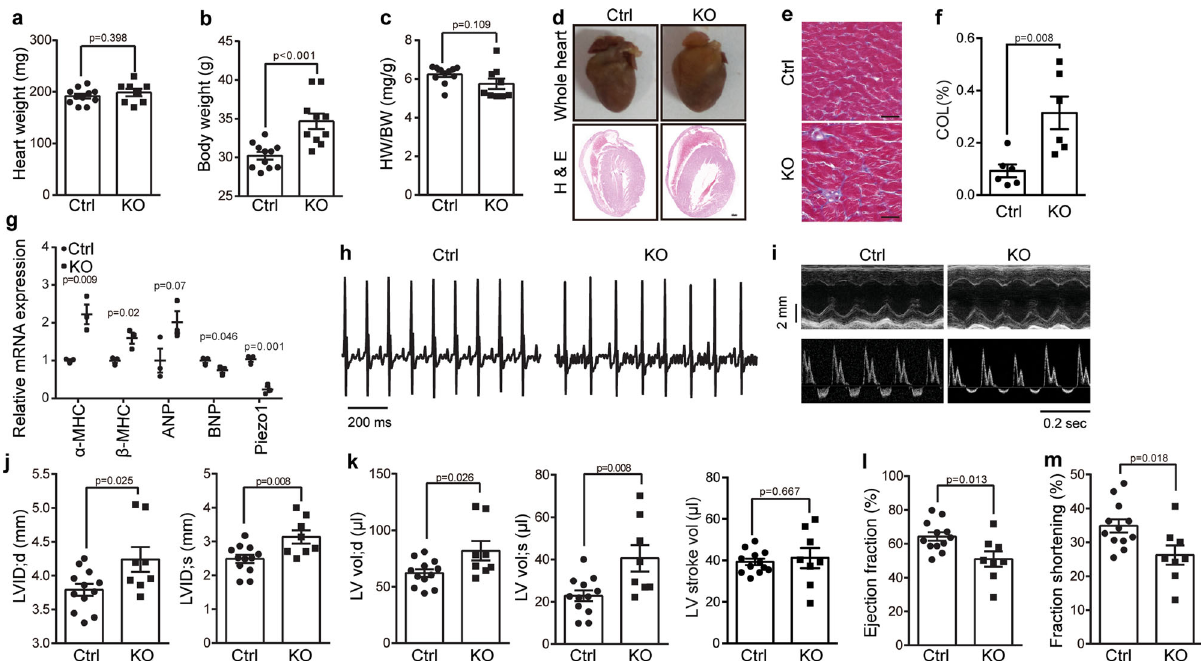
Fig. 6 Cardiac speci fi c knockout of Piezo1 impairs heart function. a – c Scatter plot of heart weight ( a ), body weight ( b ), and HW (heart weight)/BW (body weight) ratio ( c ) of 18-week old littermate Ctrl ( n = 11) and Piezo1-KO ( n = 10) male mice. Unpaired student ’ s t-test, two-sided. Values are mean ± SEM. d Histologic analysis of whole hearts or H & E stained longitudinal heart sections derived from 18-week old Ctrl and KO male mice. e Histologic analysis of the left ventricles of the Ctrl and KO hearts sectioned longitudinally and subjected to Masson ’ s trichrome staining. Scale bar, 20 μ m. f Scatter plot of collagen content in the ventricular area of the Ctrl and KO hearts derived from 18-week old mice ( n = 6). Unpaired student ’ s t-test, two-sided. Values are mean ± SEM. g RT-qPCR analysis of the normalized mRNA level of the indicated cardiac genes derived from18-week old Ctrl and KO mice ( n = 3). Unpaired student ’ s t-test, two-sided. Values are mean ± SEM. h Representative ECG recordings from 18-week old Ctrl and KO male mice. i Top panel: M-mode parasternal short-axis at mid-ventricular level of end-diastolic and end-systolic dimension of left ventricle; Lower panel: Pulsed Doppler at mitral valve in fl ow showing mitral blood fl ow velocity of early-diastolic and end-diastolic. j – m Scatter plots of echocardiographic analysis of left ventricular end- diastolic internal diameter (LVID;d) (left panel) and end-systolic internal diameter (LVID;s) (right panel) ( j ); diastolic (left panel) systolic (middle panel), and stroke volume (right panel) of left ventricle ( k ); percentage of ejection fraction ( l ); percentage of fractional shortening ( m ) determined from transthoracic M-mode tracings from 18-week old Ctrl ( n = 12) and KO ( n = 8) mice. Unpaired student ’ s t-test, two-sided. Values are mean ± SEM. All experiments were conducted with male